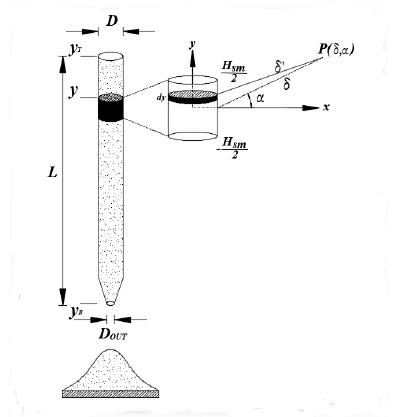
Figure 2. General behaviour of the CLS associated with di ff erent lengths of H sm . Cartesian representation of | Sin c( σ ) | .